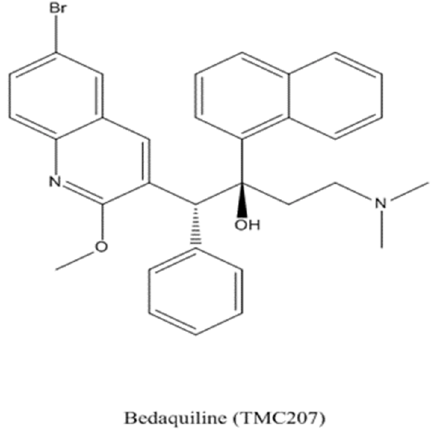
Figure 1. Bedaquiline structural